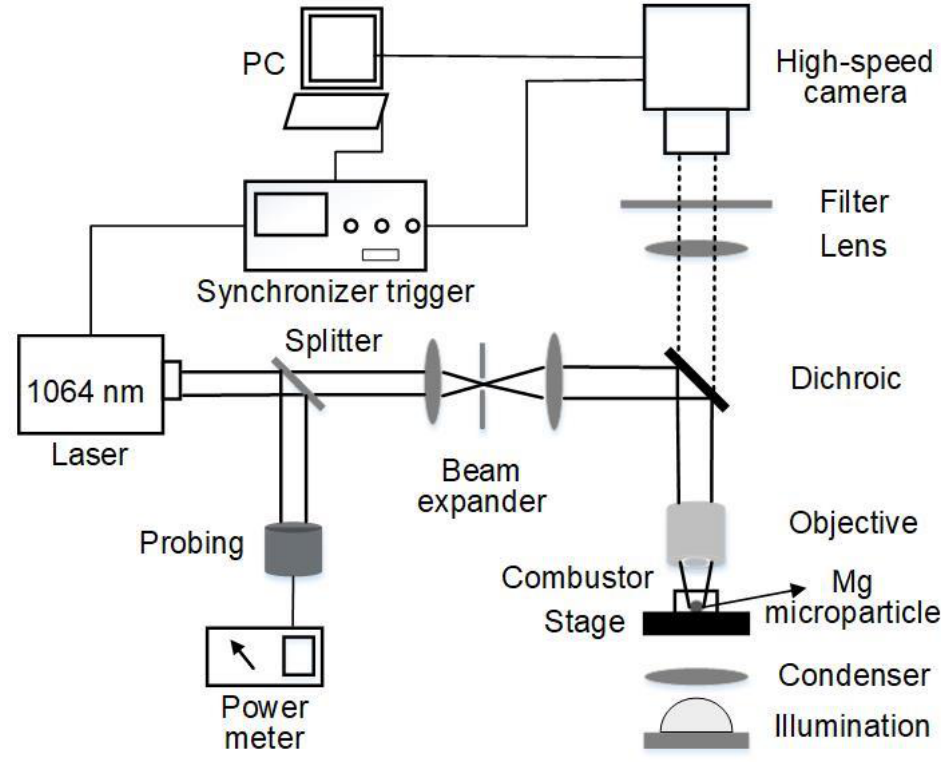
Figure 5. Schematic of experimental